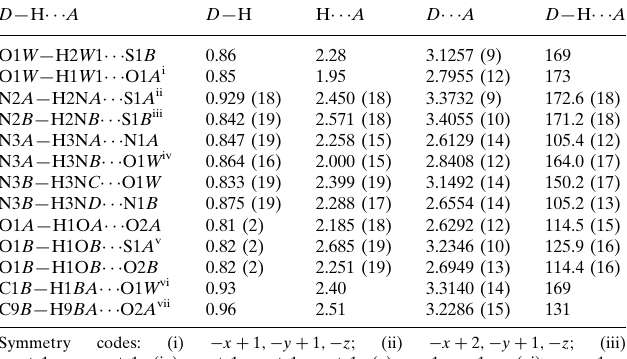
Absorption correction: multi-scan ( SADABS ; Bruker, 2005)